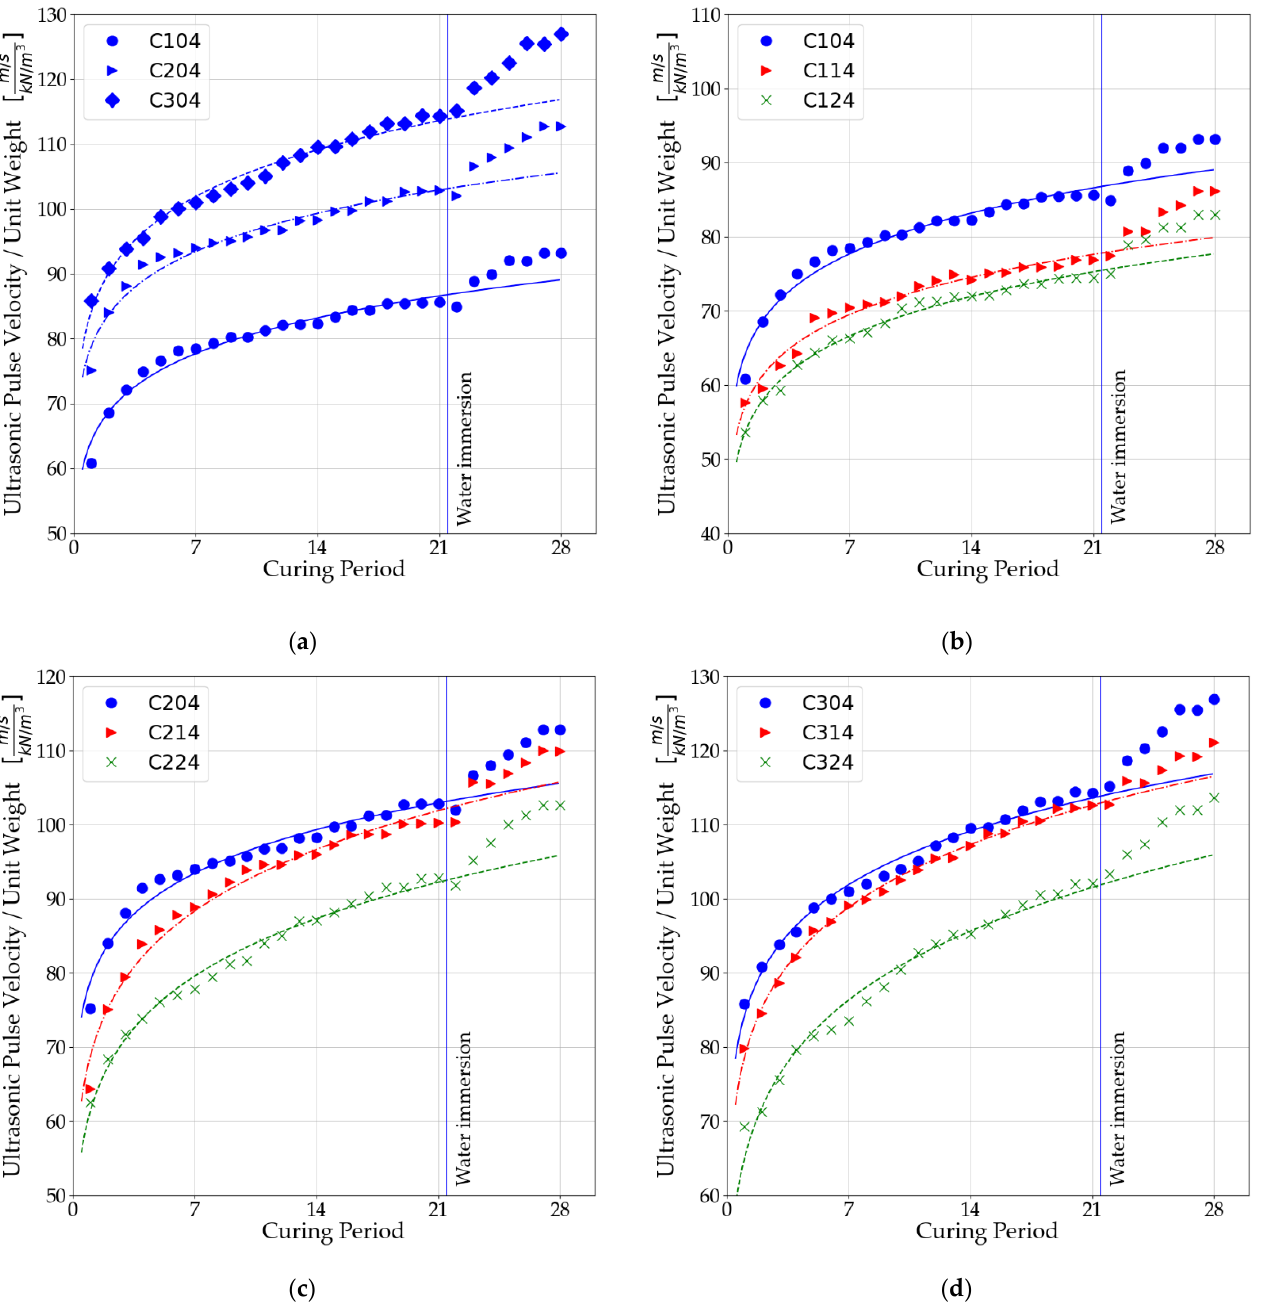
Figure 7. Influence of curing period on wave velocity, normalized by the unit weight: ( a ) Mixtures without polypropylene fibers; ( b ) mixtures with 3% binder; ( c ) mixtures with 5% binder; ( d ) mixtures with 7% binder.